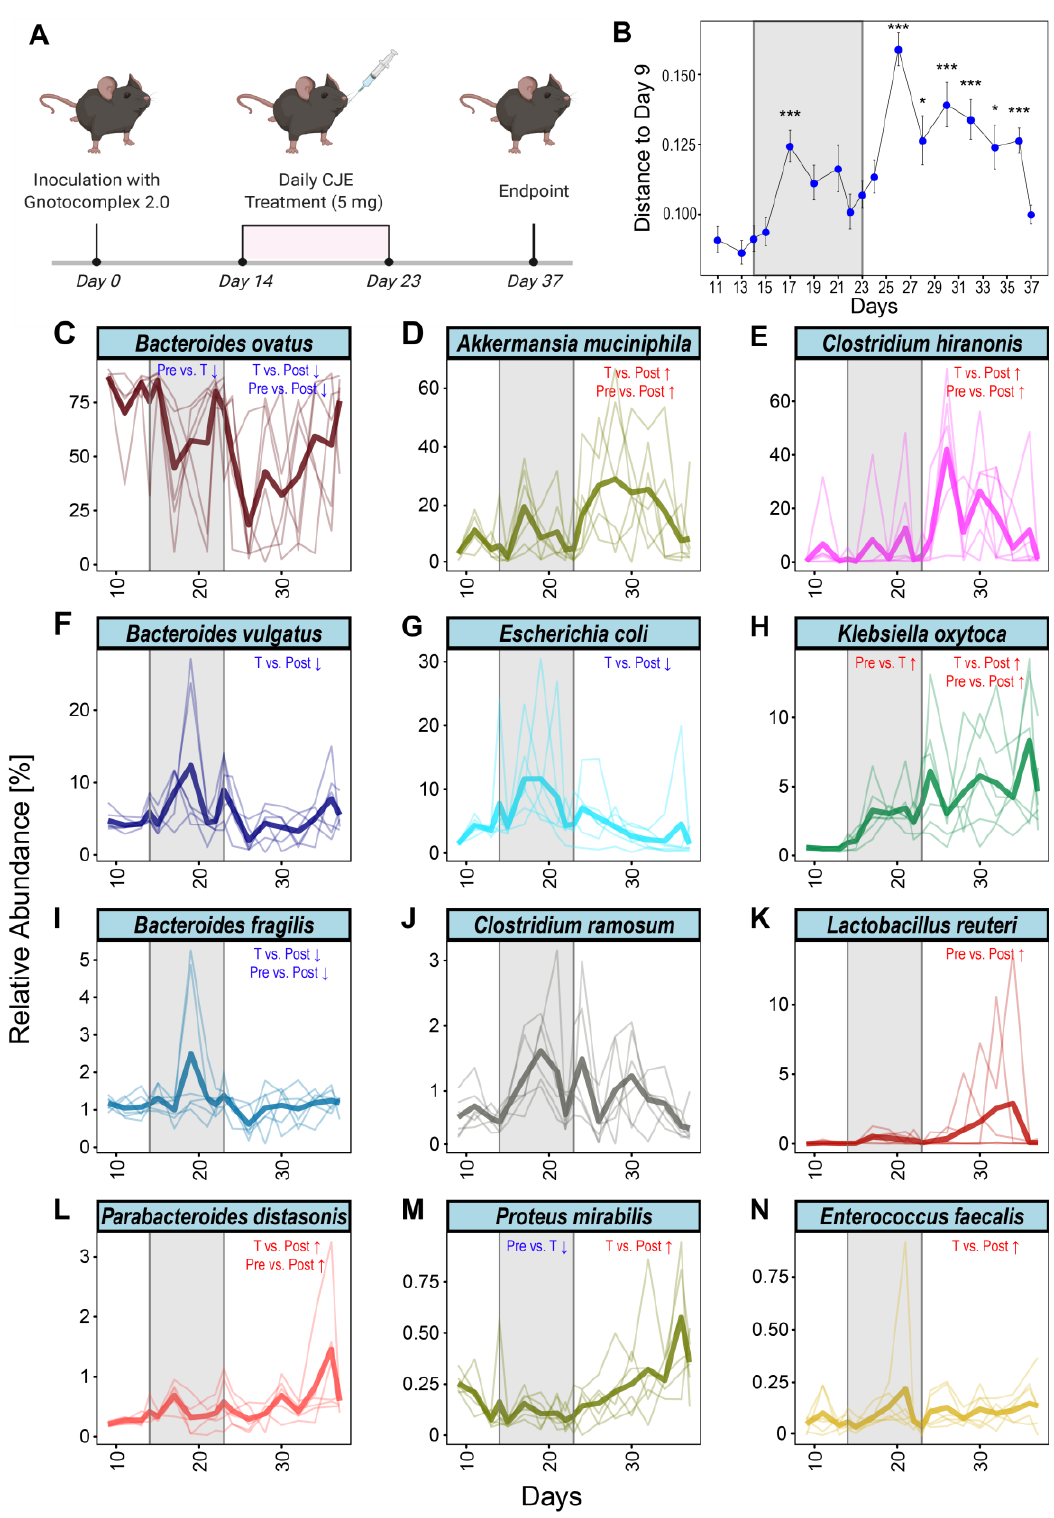
FIGURE 2: CJE treatment modulates the intestinal microbiome in a gnotobiotic mouse model. (A) Schematic of the experimental setup. (B) Bray Curtis distance of the microbial compositions related to the pre-treatment time point day 9. Points and error bars represent mean and standard error of the mean. *: p ≤ 0.05, ***: p ≤ 0.001. (C-N) Longitudinal depiction of the mean relative abundance throughout the experi- ment for the 12/15 bacteria that persistently colonized the gnotobiotic mice and were regulated in response to the CJE treatment. Lighter lines show individual replicates. Data for indicated statistical tests are summarized in Figure